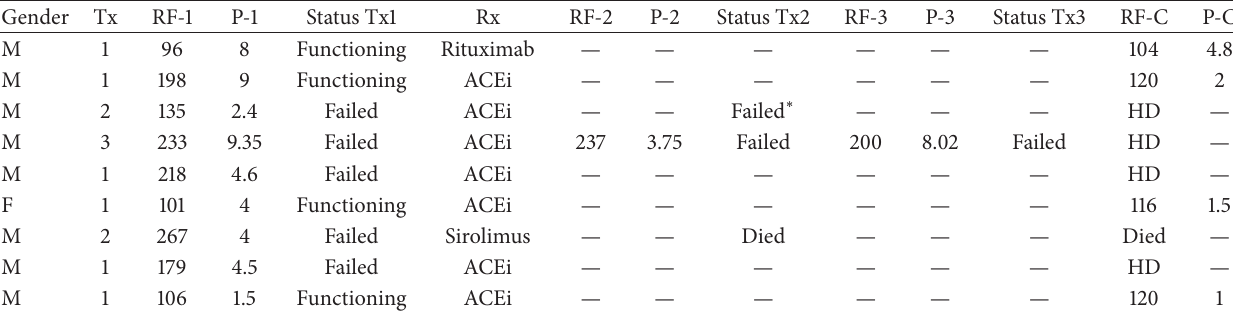
Table 2: The treatment and outcome of individual patients with recurrent membranous